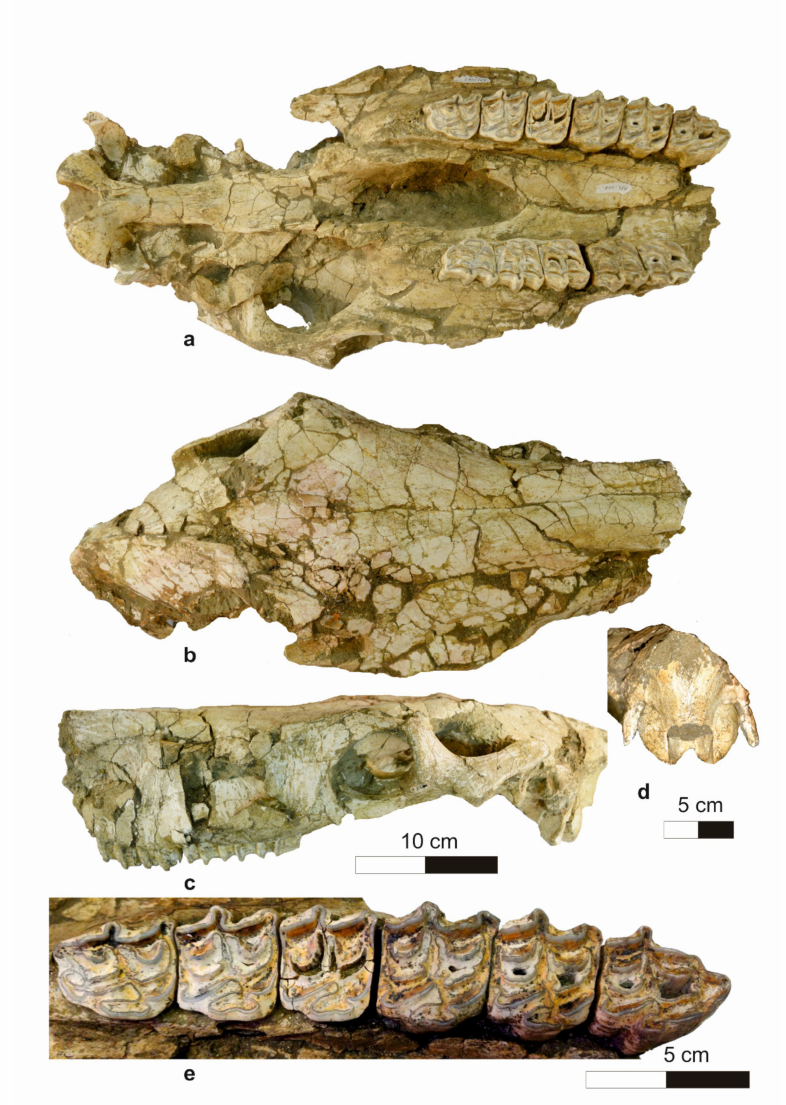
Figure 5. Equus apolloniensis , APL-147; ( a – e ) cranium, ( a ) ventral view, ( b ) dorsal view, ( c ) left lateral view, ( d ) occipital region, and ( e ) right tooth